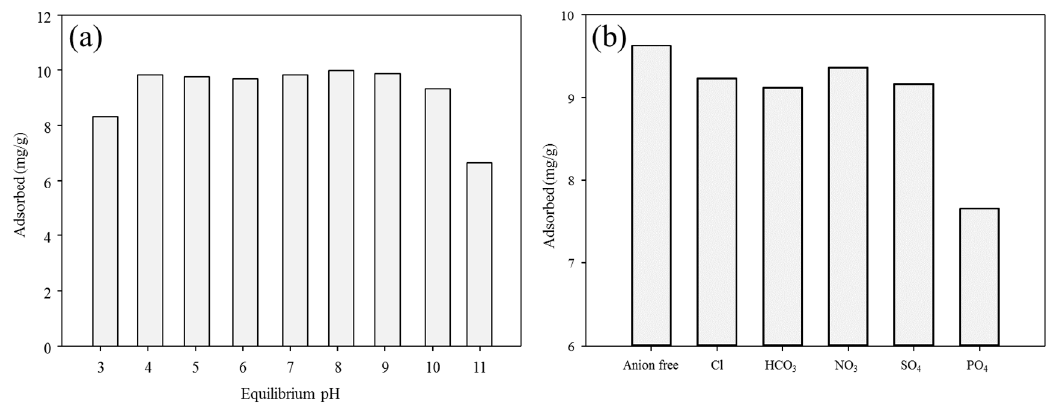
Figure 5. The e ff ects of ( a ) pH and ( b ) co-existing anions (pH = 7, 25 ◦ C) on antimony adsorption by Figure 5. The effects of ( a ) pH and ( b ) co-existing anions (pH = 7, 25 °C) on antimony adsorption by BP.